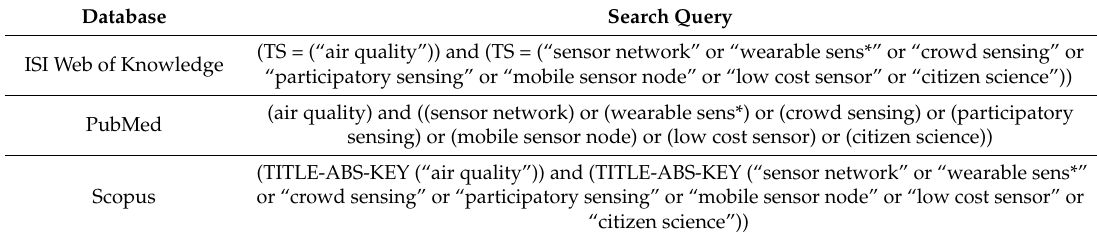
Table 1. Query used for the search in three different databases: ISI Web of Knowledge, PubMed and